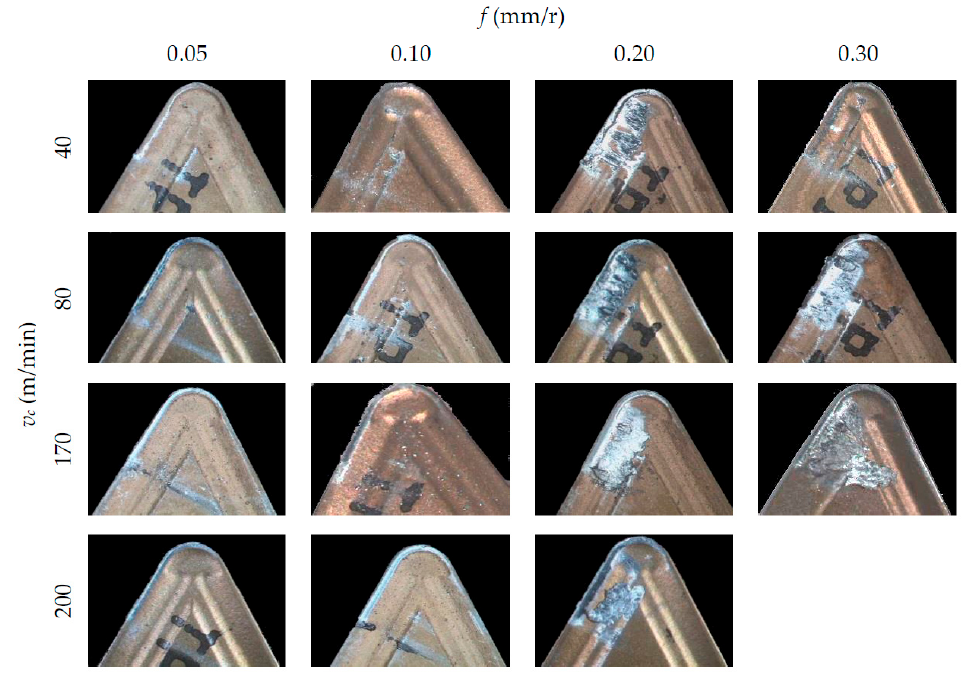
Figure 6. SOM images (30×) of the rake face, for a p = 2 mm.